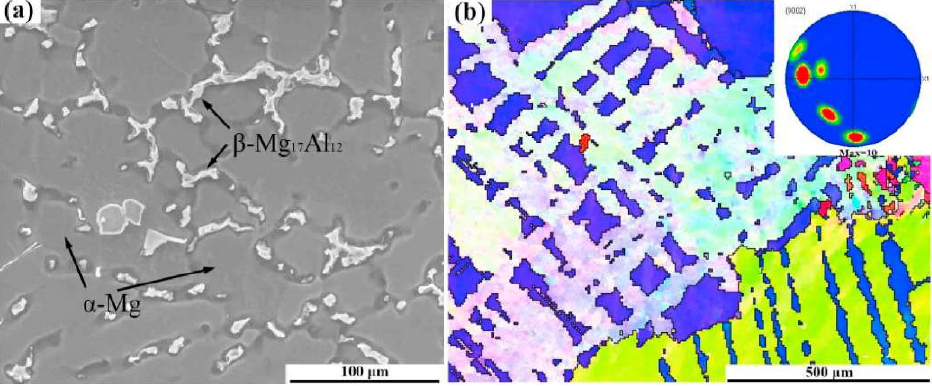
Figure 2. As-cast AZ61 Magnesium alloy ( a ) SE micrograph ( b ) inverse pole figure [39]. It is the α -Mg phase and the secondary β -Mg 17 Al 12 phase that AZ31 is designed to house. The twin-roll cast (TRC) has lower accumulation of the second phase on grain boundaries than conventionally cast (CC) AZ31 [40]. When comparing CC AZ31 and TRC AZ31, you can see that the grain size of the former is 300 µ m while the latter is 200 µ m. There is also more deformation near the surface during the TRC than in the middle of the strip [41]. The surface grain size is reduced to 50 µ m as a result. After 10 h of ageing at 450 ◦ C, the grains of cast AZ31 were seen to have become slightly coarser. The secondary β -Al 12 Mg 17 phase in the cast AZ31 partially dissolves with age and almost no particles were observed within the grains. Morphology reveals that alloy microstructures are significantly impacted by partial remelting temperatures [42]. After rolling, grain sizes were reduced for all materials, and it was noticed that this was also correlated with a decrease in rolling temperature. In particular, they found that the material’s yield strength had increased during the treatment [43]. Dendritic structure is drastically reduced